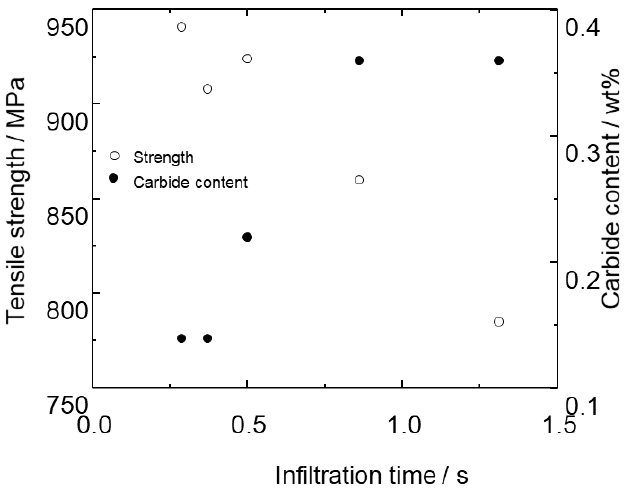
Figure 12. Carbide content at the fibre–matrix interface and the average composite strength versus the contact time of the fibre with a liquid matrix at a temperature of 730 °C. Experimental data published in [44].